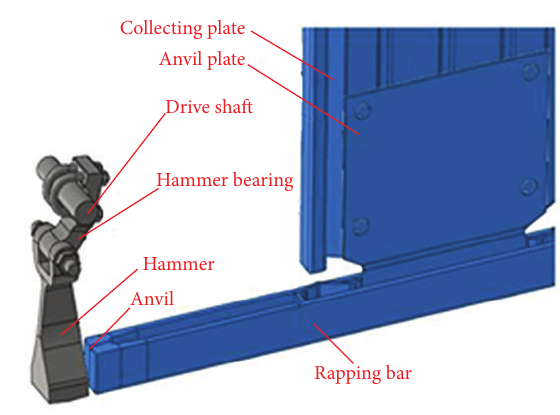
Figure 10: Numerical modeling relevant to all parts of the collecting plates and rapping system of the electrostatic filter (tumbling hammer, anvil plate rapping bar, and collecting plate).